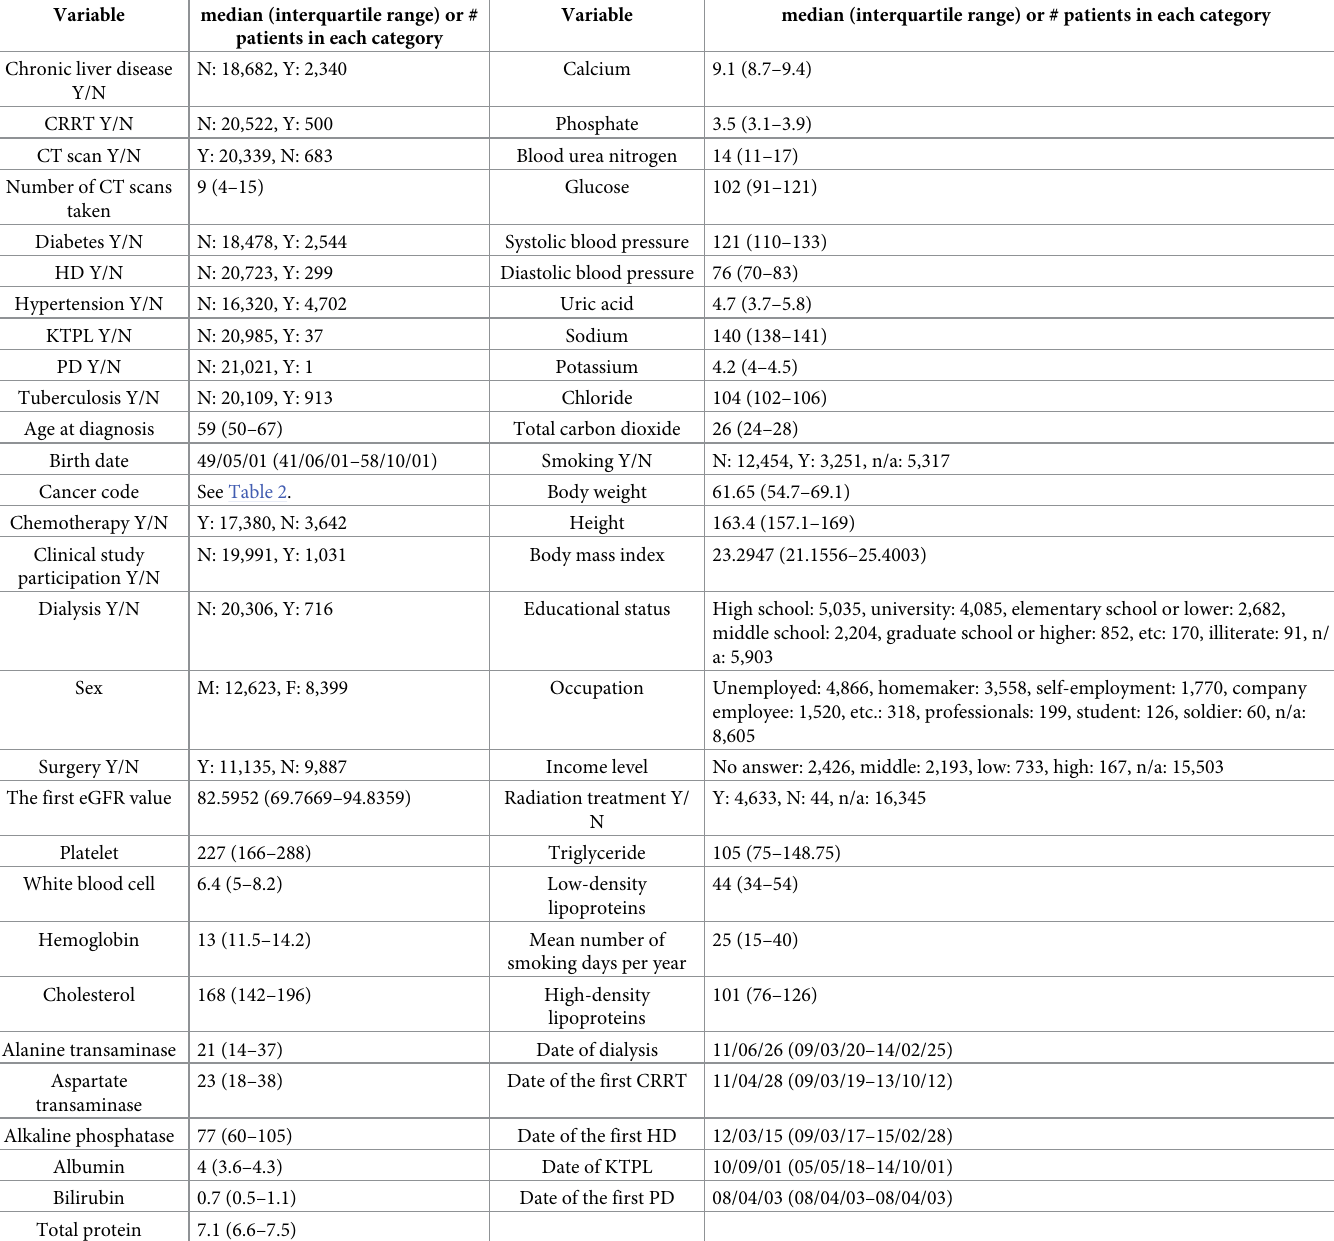
Table 1. Descriptive statistics of non-temporal variables: The median and interquartile range are shown for non-categorical variables, and the number of patients in each category is shown for categorical variables. Variable median (interquartile range) or # Variable median (interquartile range) or # patients in each patients in each category